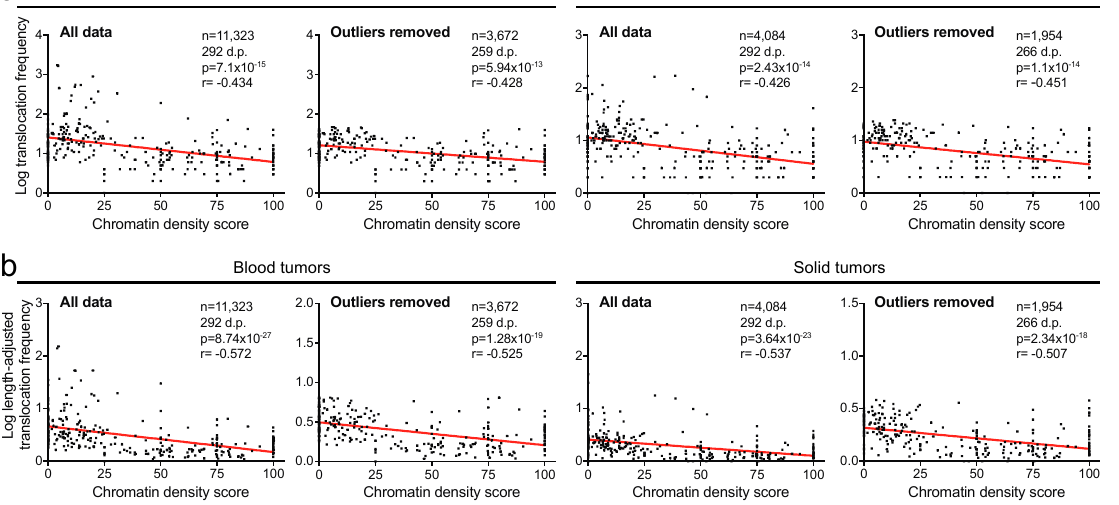
Figure 2. Translocation breakpoints preferentially occur in euchromatin. ( a ) Scatter plots of chromatin density score of cytogenetic chromosome bands correlated with translocation frequencies within these bands in blood and solid tumors. Analyses are also shown after outlier removal. ( b ) Scatter plots of chromatin density score of cytogenetic chromosome bands correlated with length-adjusted translocation frequencies of the bands in blood and solid tumors. D.p., data points. Statistics: see Figure 1.